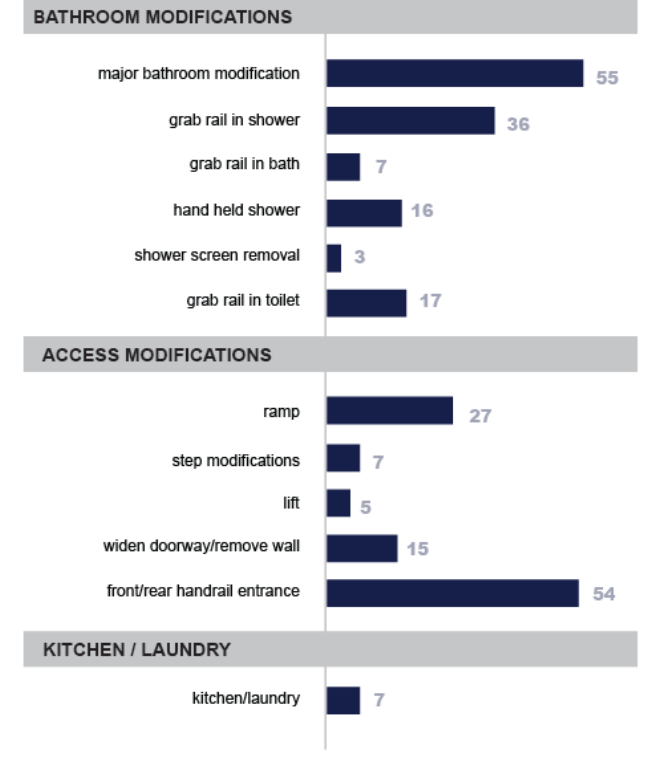
Figure 1. Home modification frequency by type. Note: Where participants received major bathroom modifications, they were not included in the count for other, itemised bathroom modifications. Kitchen and laundry modifications refer to cabinet height/design changes, widening of work areas or mounting of appliances for easier access.